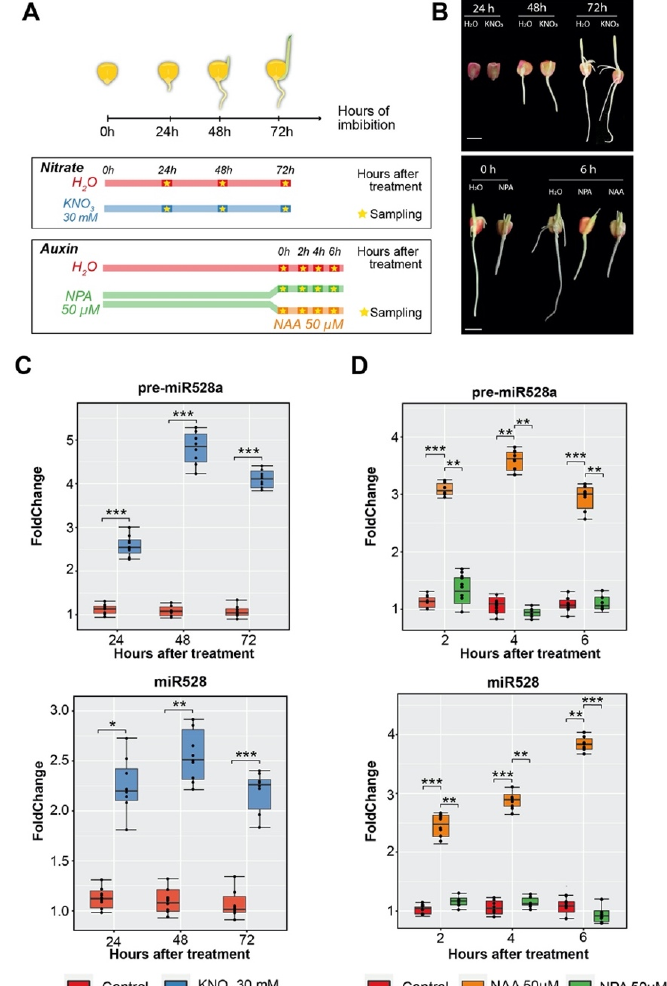
Figure 4. The effect of exogenous nitrate and auxin treatments on pre-miR528a and mature miR528 accumulation during maize seed imbibition. ( A ) Experimental design for treatment application during seed imbibition and seedling establishment. To evaluate high nitrate concentration, maize seeds were incubated in water (control) or 30 mM KNO 3 for 72 h with sampling at 24, 48, and 72 h of continuous treatment. For exogenous auxin application, seeds were imbibed for 72 h in water (control) or 50 µM N-1-naphthylphthalamic acid (NPA, auxin transport inhibitor). Afterward, a portion of the NPA-treated seedlings was transferred to a 50 µM 1-Naphthalene Acetic Acid (NAA) solution and samples were collected at 0, 2, 4, and 6 h after the auxin pulse. ( B ) Representative images for maize seed germination and seedling establishment at 24 h, 48 h, and 72 h of imbibition under high nitrate condition (top) or 72 h imbibed seedlings at 6 h after the application of exogenous auxin (bottom). Scale bar = 1 cm. ( C ) Relative accumulation levels of miR528 precursor and mature form in samples treated with nitrate. ( D ) Relative accumulation levels of miR528 precursor and mature form in samples treated with exogenous auxin. The expression levels were normalized using 18S rRNA (for precursor) and U6 snRNA (for mature miRNA) accumulation. Error bars represent standard errors of means from at least three independent replicate experiments. * p < 0.05, ** p > 0.01, and *** p < 0.001 (Data were analyzed by one-way ANOVA with Tukey post hoc test comparing treated samples to control for each time point).